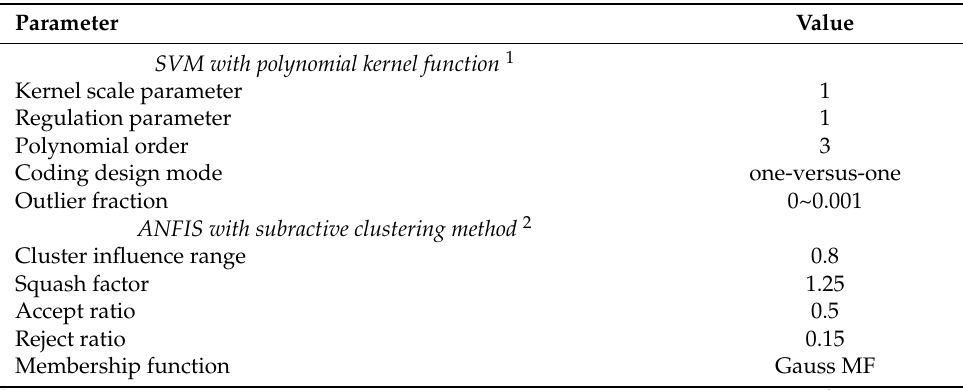
Table 4. The critical parameters used in the SVM and ANFIS